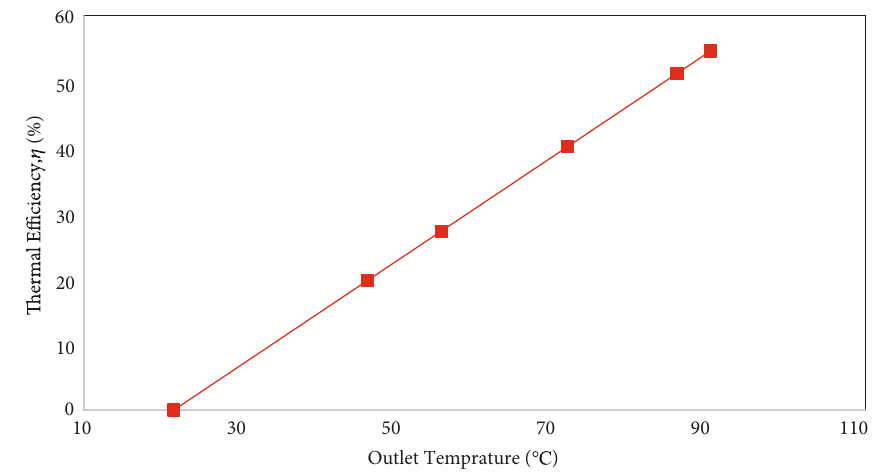
Figure 11: Thermal e ffi ciency of the